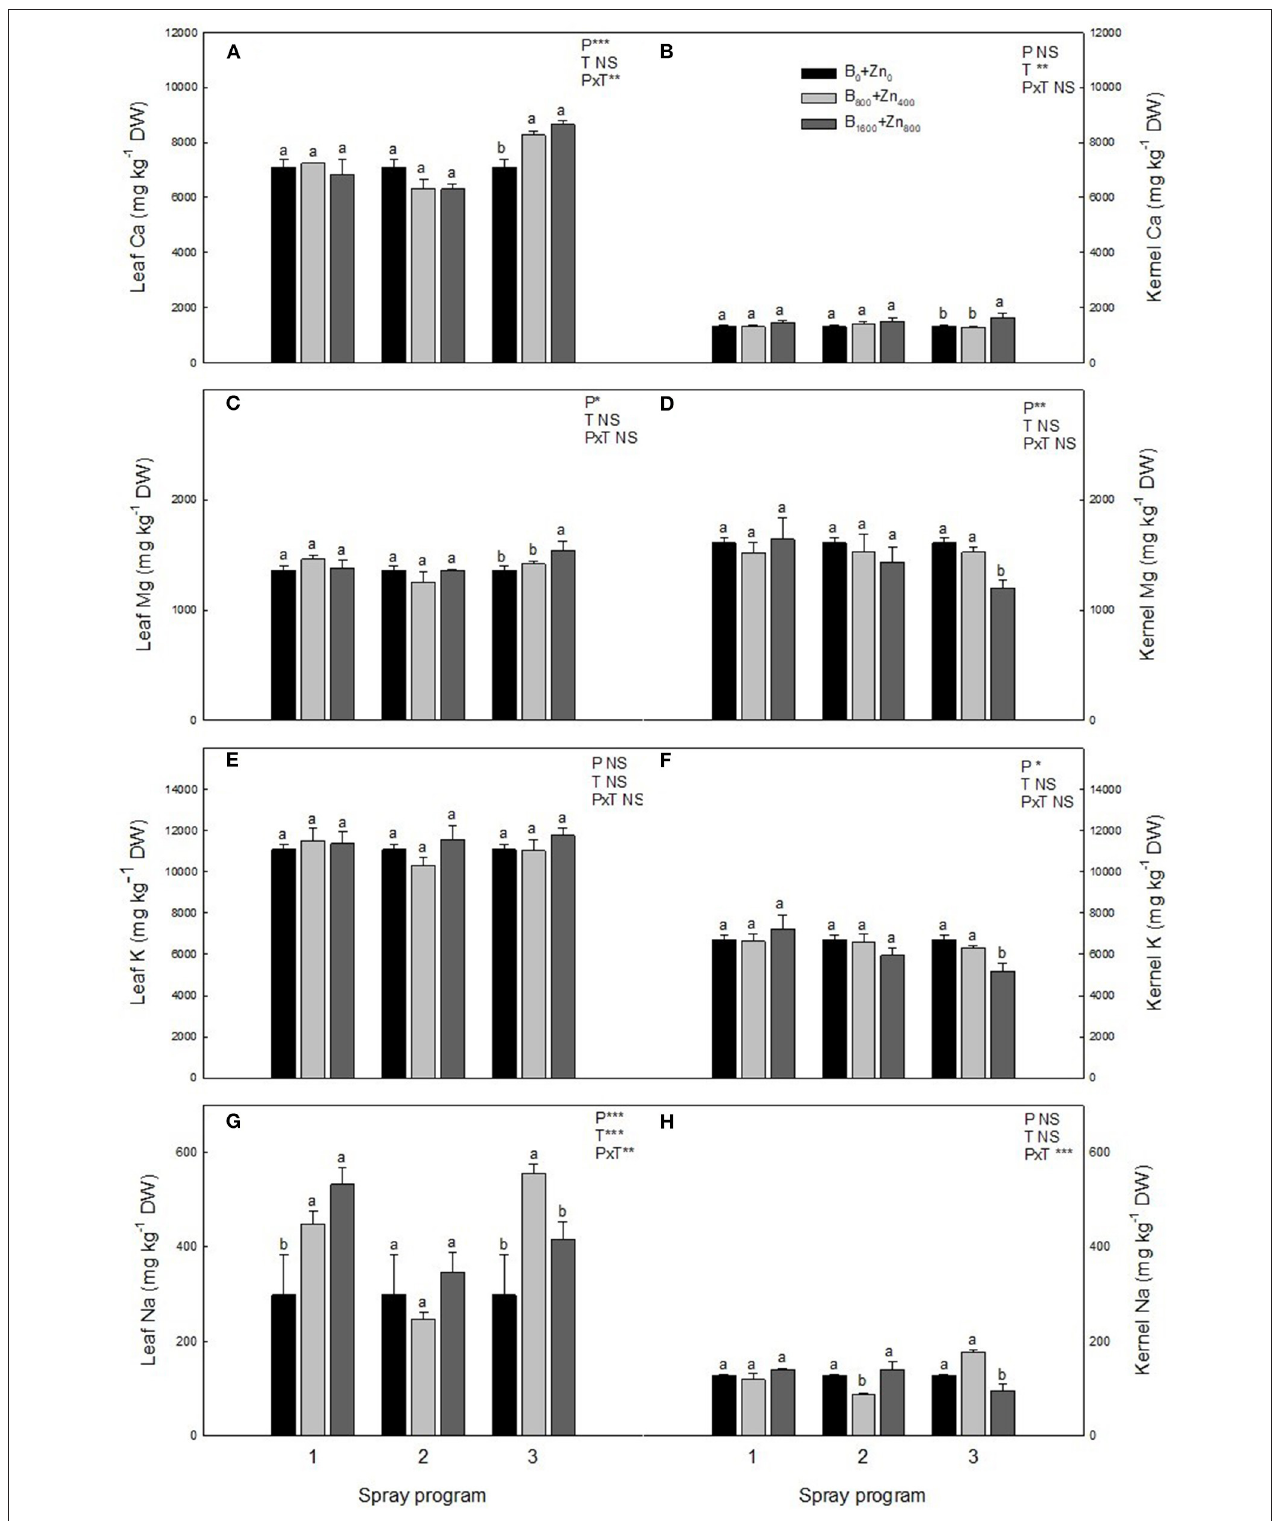
FIGURE 3 | Calcium, Mg, K, and Na concentrations (mg kg − 1 DW) in leaves (A,C,E,G) and kernels (B,D,F,H) of hazelnut trees depending on the applied spraying program. Values represent the mean ( n = 3) ± SE. Different lowercase letters indicate statistically significant differences ( P ≤ 0.05) among treatments within each spray program. Two-way ANOVA results are shown (NS, not significant, P > 0.05; * P < 0.05; ** P < 0.01; *** P < 0.001).